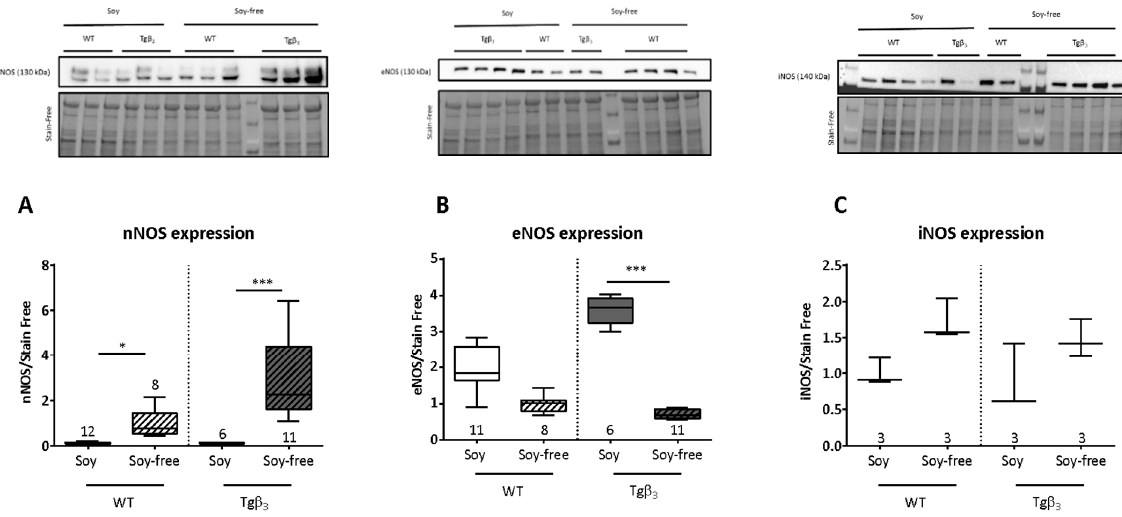
Figure 2. Changes in • NO synthases (NOS) protein expression was performed by Western blot analysis for neuronal NOS (nNOS) protein expression. Male—WT—Soy, n = 12; Male—WT—Soyfree, n = 8; Male—Tg β 3 —Soy, n = 6; Male—Tg β 3 — Soyfree, n = 11 ( A ), eNOS protein expression. Male—WT—Soy, n = 11; Male—WT—Soyfree, n = 8; Male—Tg β 3 —Soy,